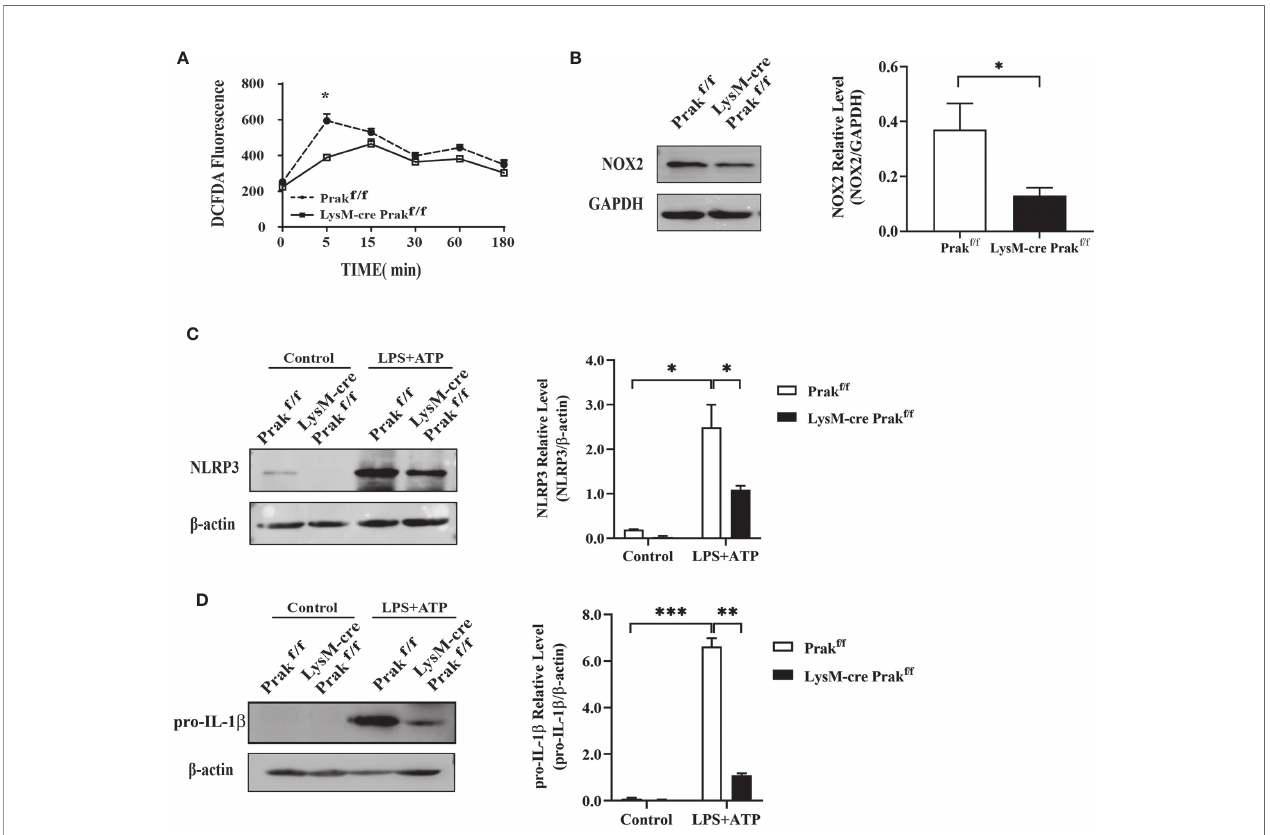
FIGURE 4 | ROS production and in fl ammasome activation in Prak -de fi cient macrophages. (A) Peritoneal macrophages were incubated with L. monocytogenes and harvested at different time points. ROS levels were determined by staining 10 m M DCFDA for 30min at 37°C. Data from three independent experiments are shown as mean ± SD. * P < 0.05 by two-way ANOVA. (B) NOX2 expression was detected by Western blotting in macrophages Representative blots out of 3 independent experiments are shown on the left. The ratio of NOX2/GAPDH is shown as mean ± SD on the right. * P < 0.05 by t -test. (C, D) TG-elicited peritoneal macrophages were allowed to rest overnight. In fl ammasome activation was induced by incubating with LPS (500 ng/mL) for 4 h, followed by stimulation with ATP (3 mM) for 0.5 h. The expression of NLRP3 (C) and IL-1 b (D) was assessed by western blotting. Representative blots out of 3 independent experiments are shown on the left. The ratio of NLRP3/ b -actin is shown as mean ± SD on the right. * P < 0.05 by t -test. ** P < 0.01, *** P <